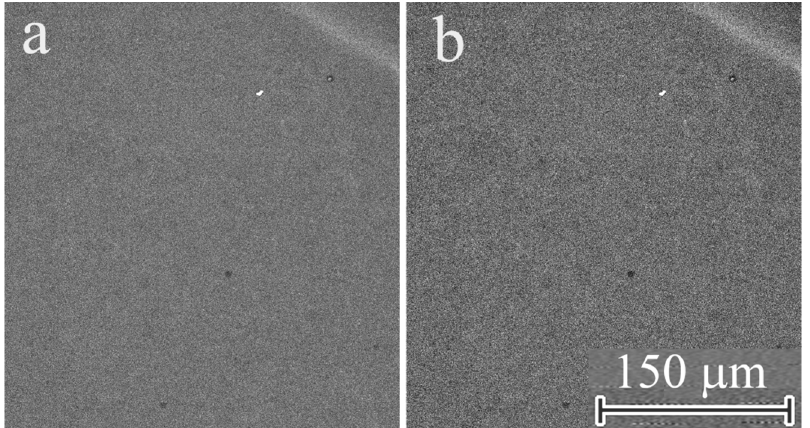
Figure 3. The secondary electron images of the region shown in Figure 1 before ( a ) and after applying − 15 V ( b ). The light line in the upper right corner is the edge of the Al contact.